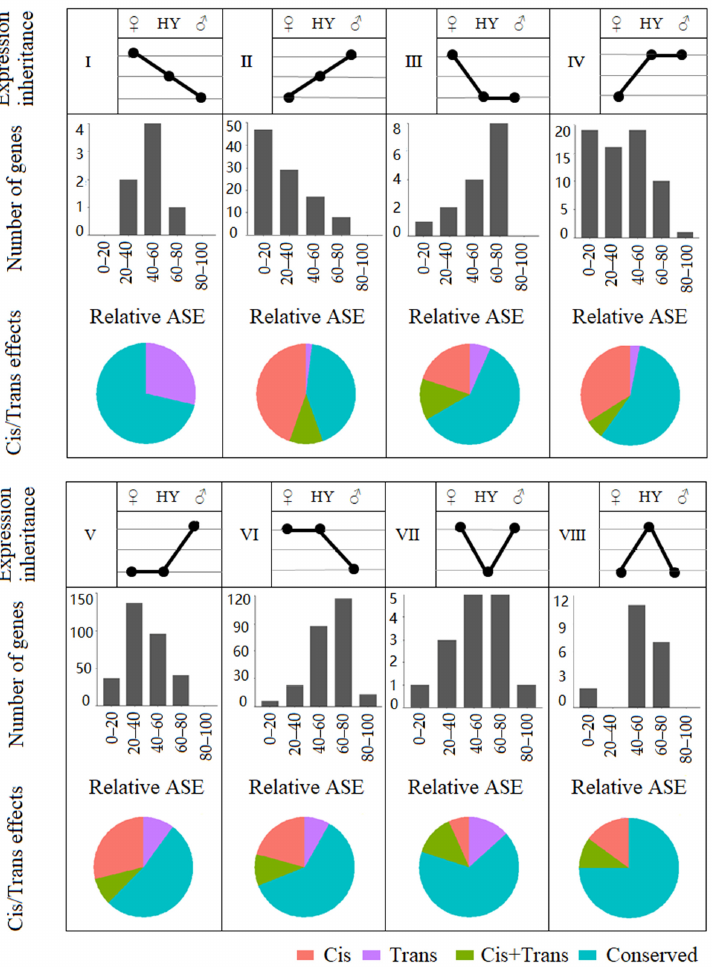
Figure 5. Comparison of relative allele-specific expressions (ASEs) and cis- and trans-effects according to seven expression inheritance patterns in HY1. The relative ASE represents the expression of maternal alleles as a percentage of the total gene expression in the hybrid (% FP HY ). The pie charts show the proportion of genes showing cis-effects, trans-effects, or both cis- and trans- (cis + trans) effects. Genes showing no significant evidence of cis- or trans-effects were classified as conserved.